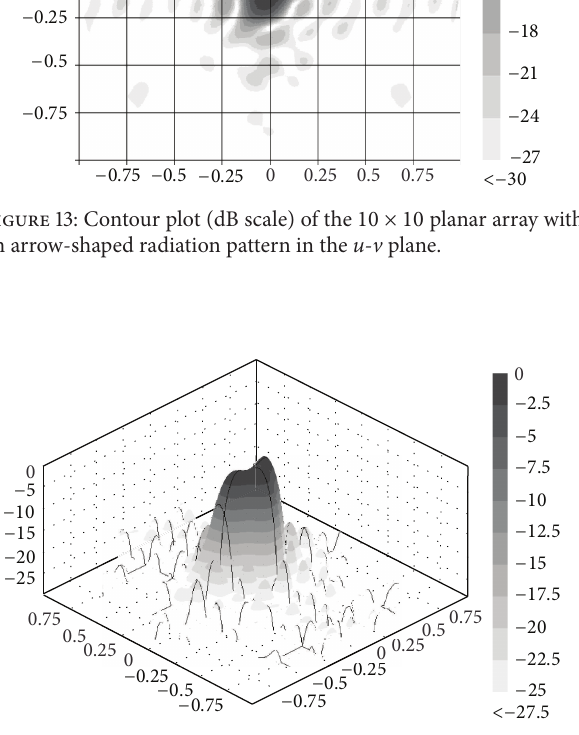
Figure 14: 3D radiation pattern (dB scale) of the 10×10 planar array with an arrow-shaped radiation pattern in the u - v plane.